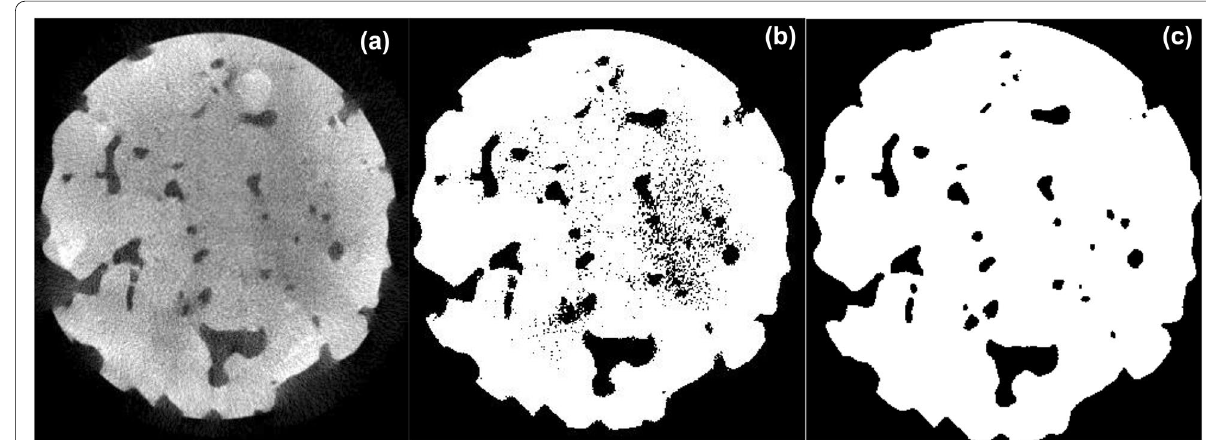
Fig. 8 Image processing a raw CT image; b binary image; and c filtered image.